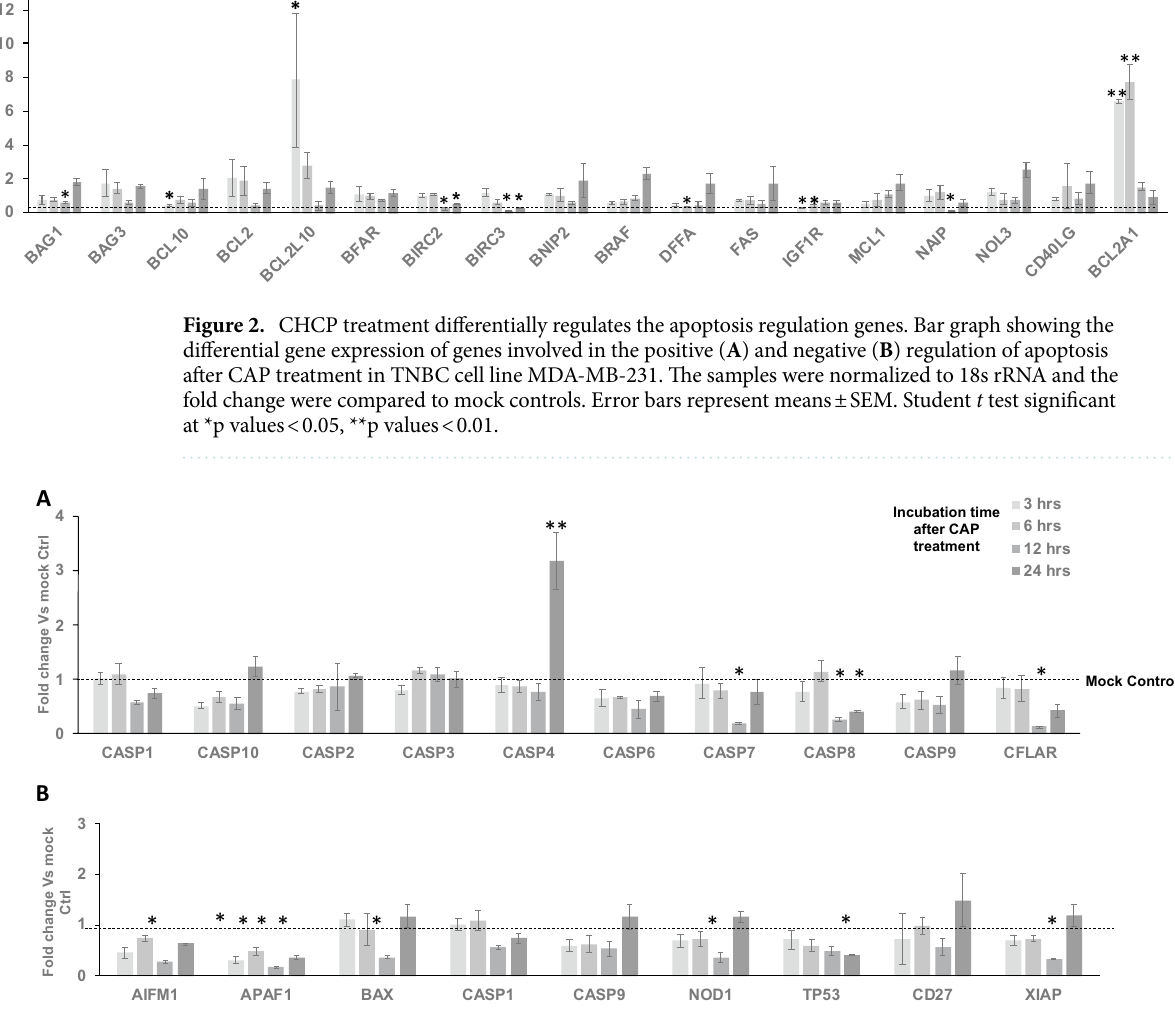
Figure 3. CHCP treatment differentially regulates Caspase genes. Bar graph showing the differential gene expression of genes involved in the caspase family ( A ) and caspase activation ( B ) regulation of apoptosis after CAP treatment in TNBC cell line MDA-MB-231. The samples were normalized to 18s rRNA and the fold changes were compared to mock controls. Error bars represent means ± SEM. Student t test significant at *p values < 0.05, *p values <